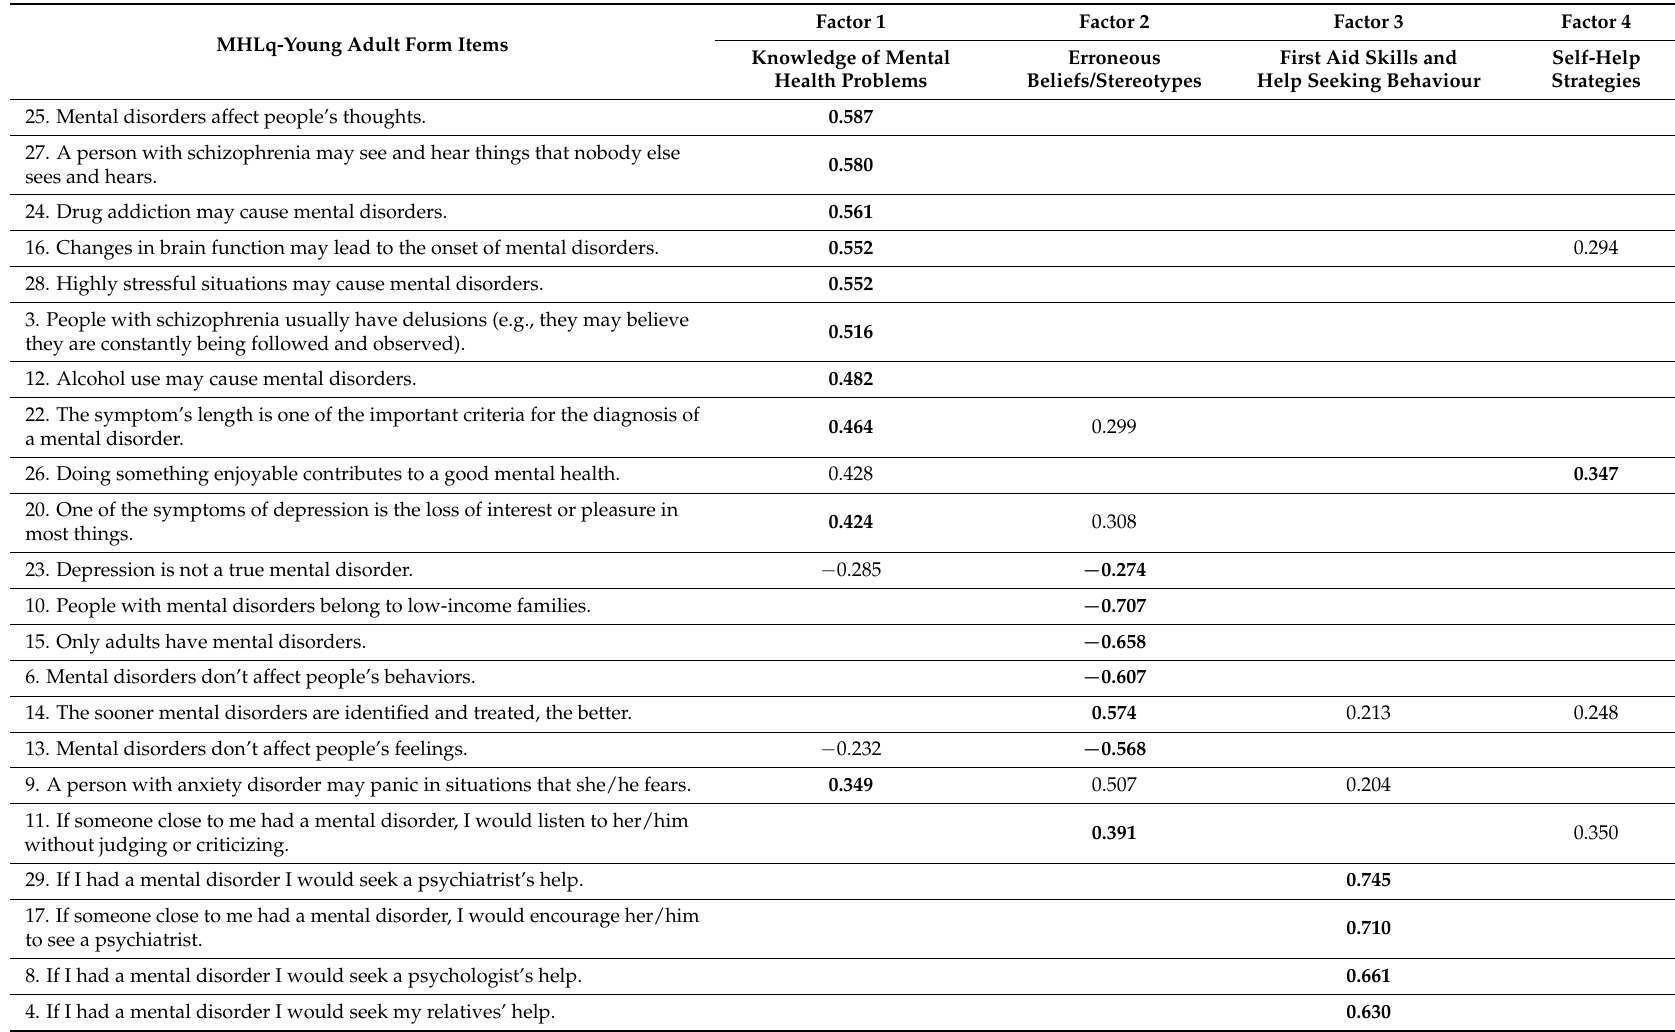
Table 3. Exploratory factor analysis of the MHLq-young adult form item description and factor loadings (final version, 29